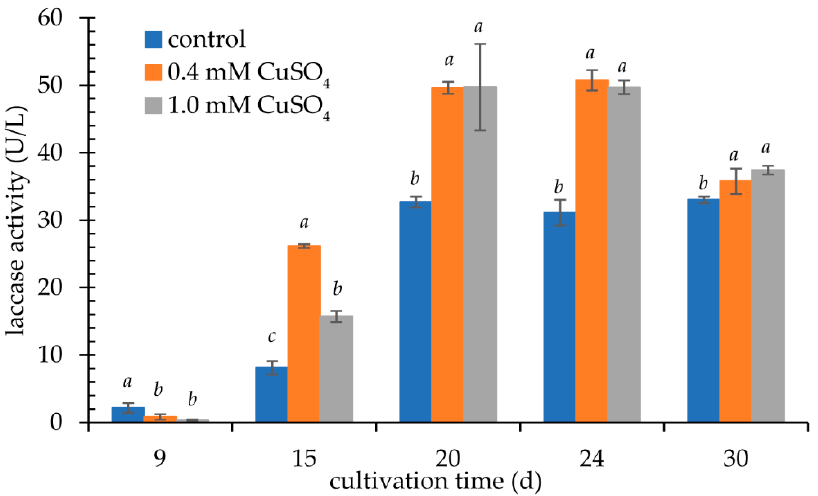
Figure 4. Influence of Cu 2+ on laccase activity (cultivation in Sivakumar medium); the data presented as the means ± SD from at least three independent experiments; the means within single culture day that are marked with different letters ( a – c ) are significantly different.